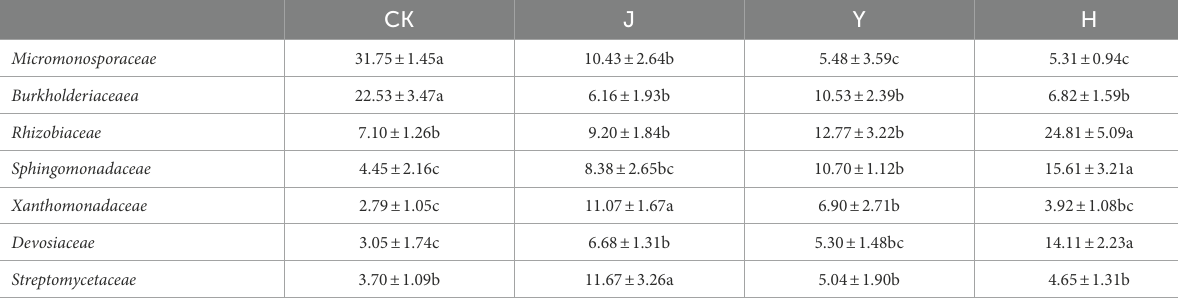
TABLE 13 Comparison of major bacterial community composition of soybean-potted root at the family level. CK